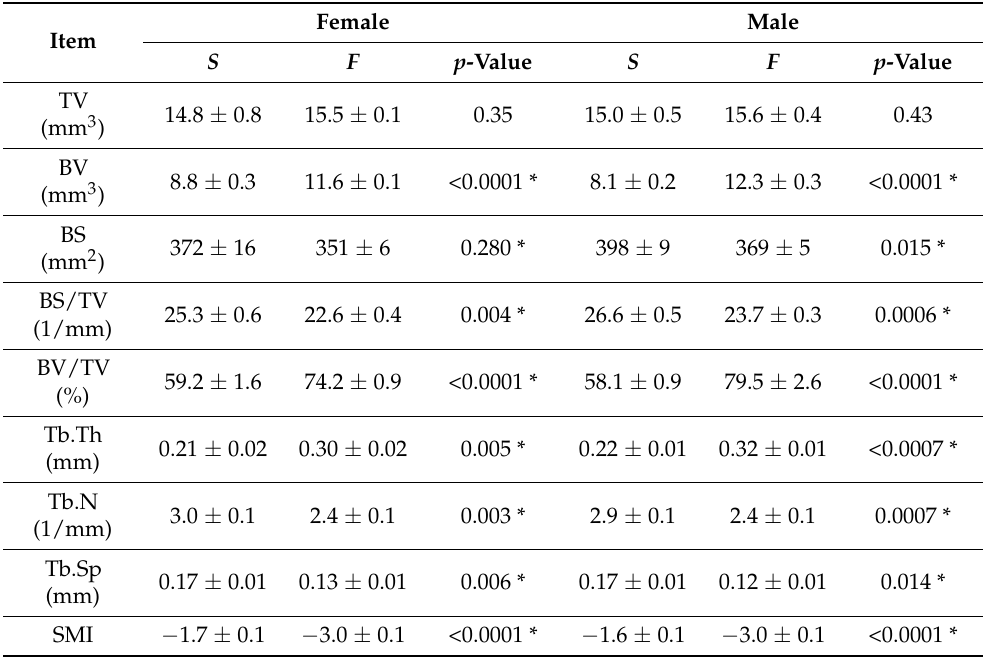
Table 4. Micro-CT measurement of the trabecular bone tissue in the proximal tibia metaphysis of female and male rats on the weaning day. Female Item